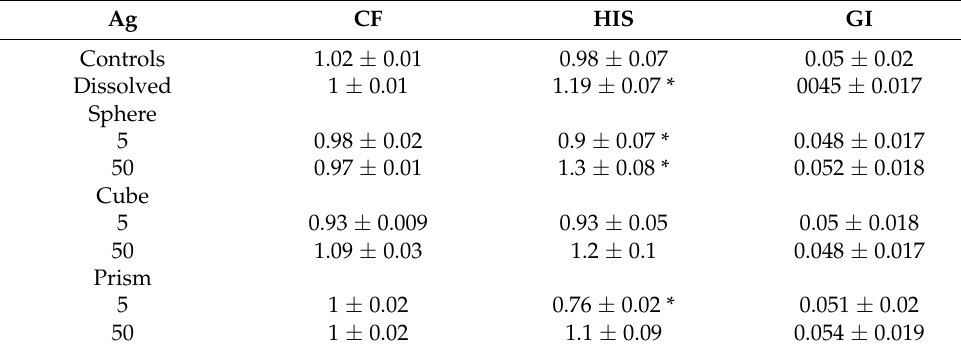
The star symbol * indicates significance from controls. CF: condition factor (wet/fork length); HIS: hepatic-somatic index (liver weight/fish weight), GI: gill index (gill weight/fish